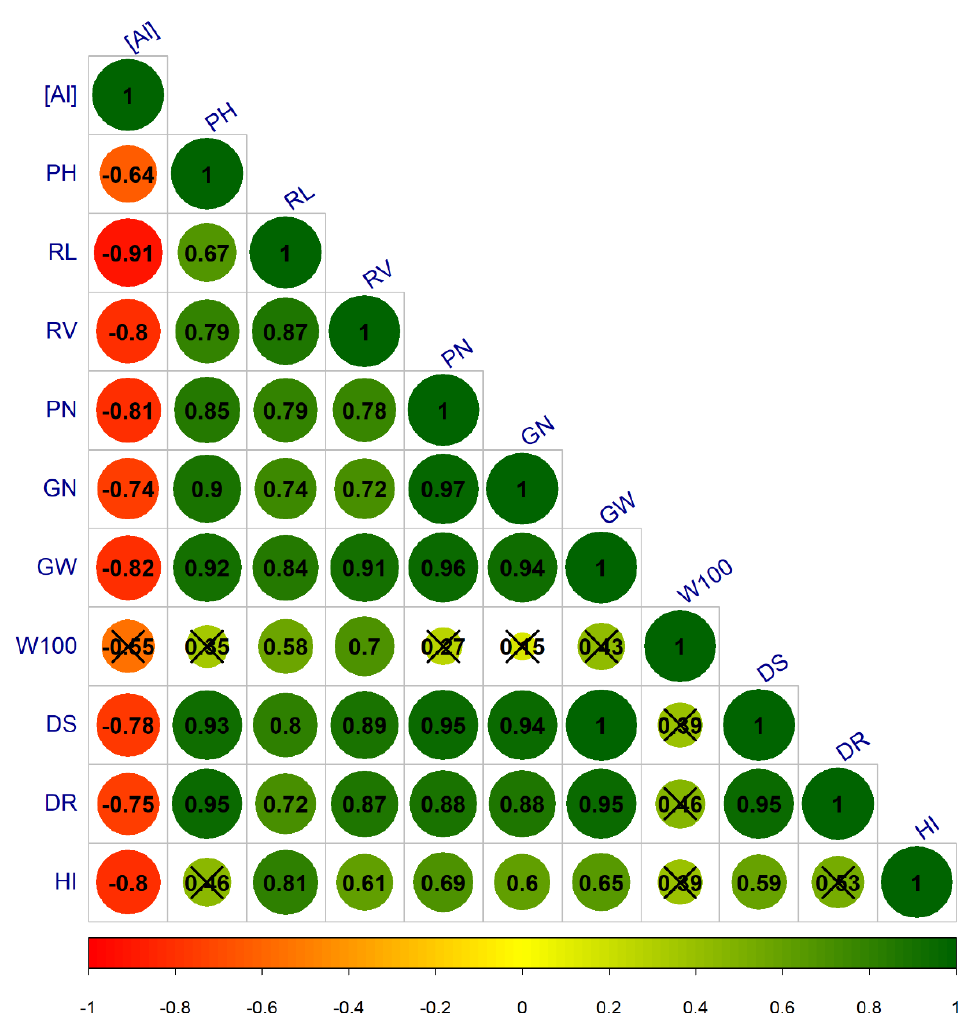
Figure 3. Pearson’s correlation analysis for Al concentrations in nutrient solution, morphological variables, and yield components based on the evaluation of common bean cultivars. [Al]—Al concentrations; (PH)—plant height; (RL)—root length; (RV)—root volume; (PN)—number of pods per plant; (GN)—number of grains per plant; (GW)—grain weight; (W100)—100 grain weight; (SD)—shoot dry weight; (RD)—root dry weight; (HI)—harvest index. (X) = not significant at 1% probability.